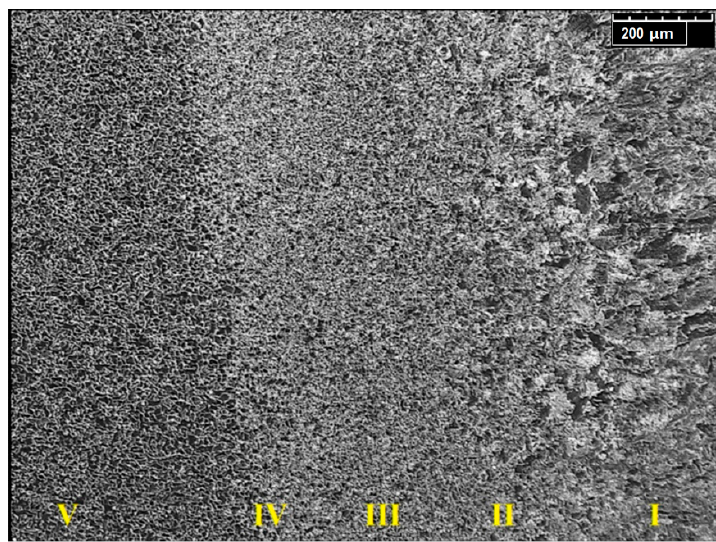
Figure 14. Microstructure of HAZ.